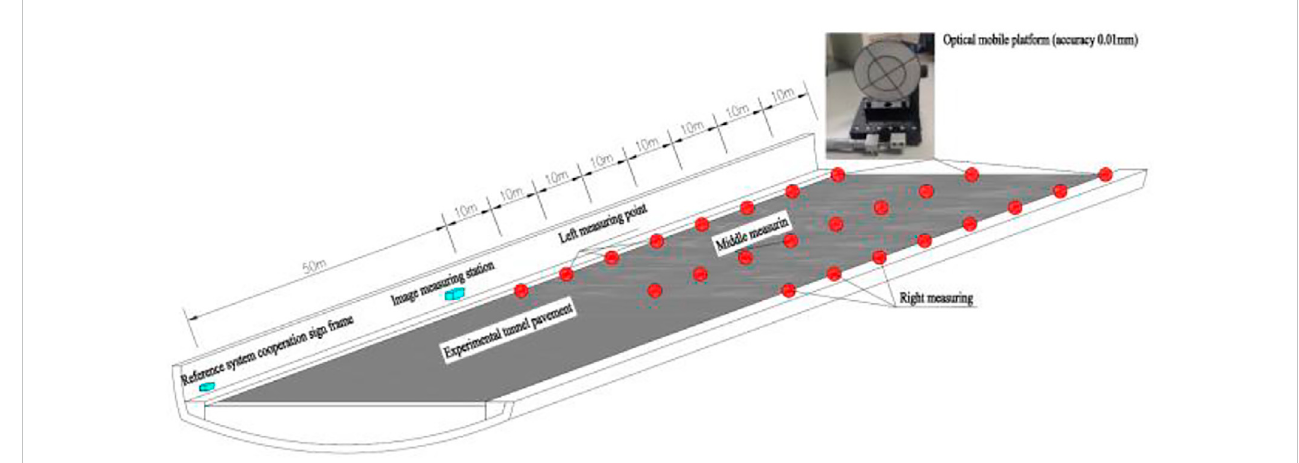
FIGURE 15 Schematic diagram of solid tunnel test.